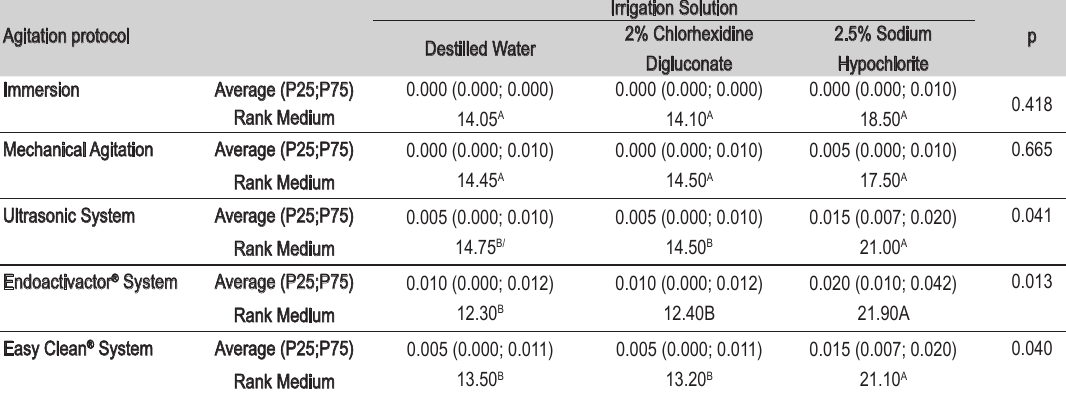
Table 3 - Average and medium ranks of the differences between the values of initial and final weight of the pulp fragments after the irrigation